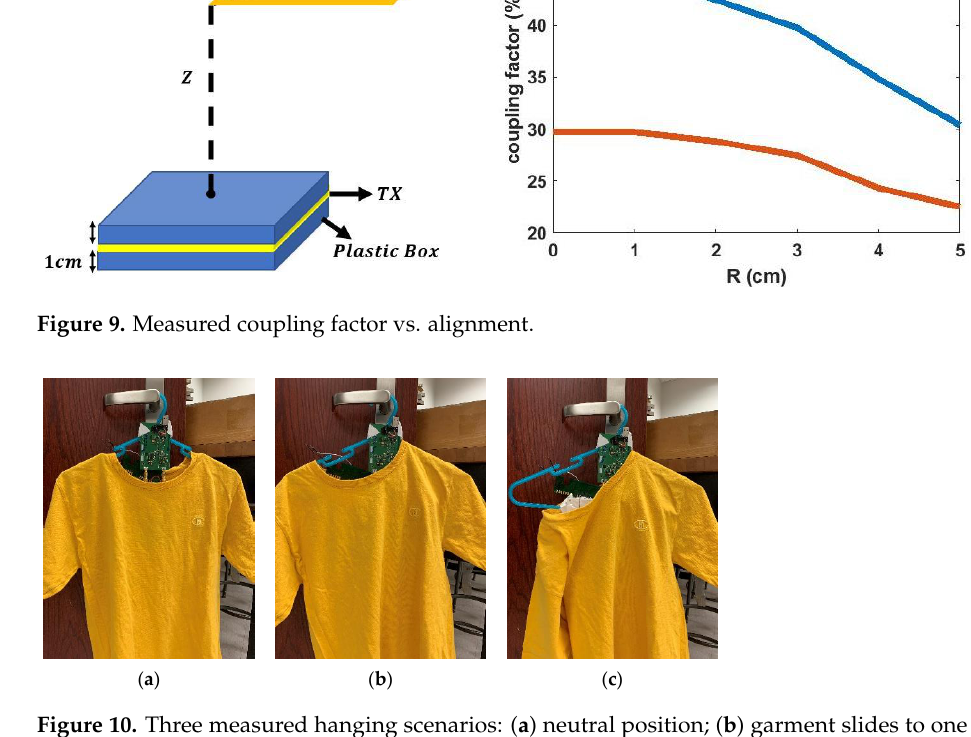
( c ) garments falls from one